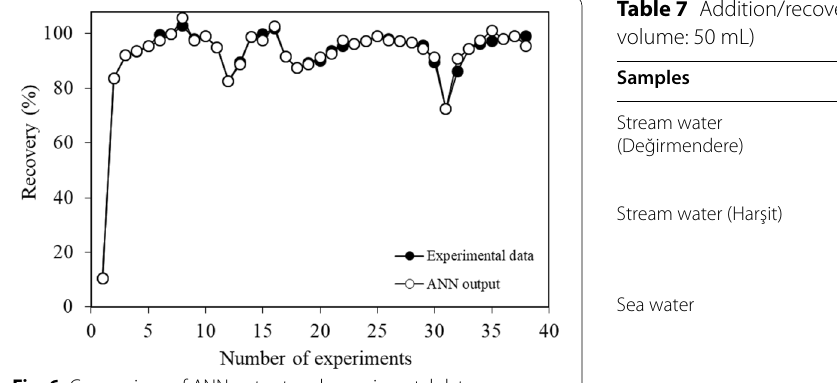
Table 7 Addition/recovery data for water samples